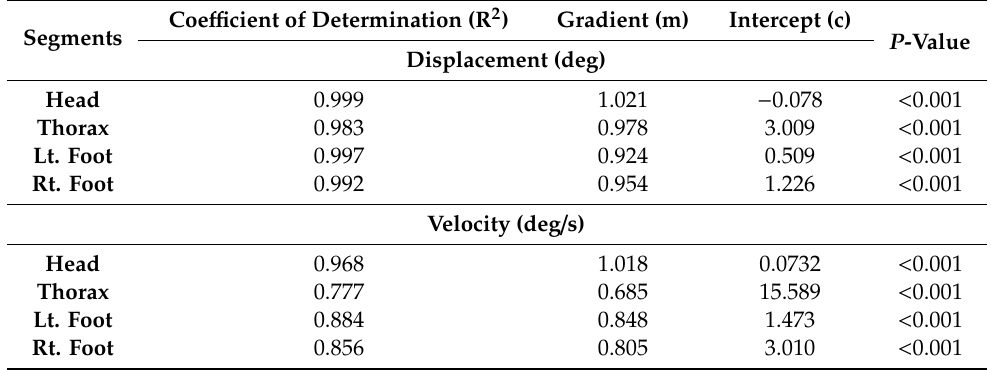
Table 1. Demonstrates the Coe ffi cient of Determination (R 2 ), the gradient (m) and the y intercept (c) of the linear regression best fit line comparing the displacement and velocity profiles of the two datasets.